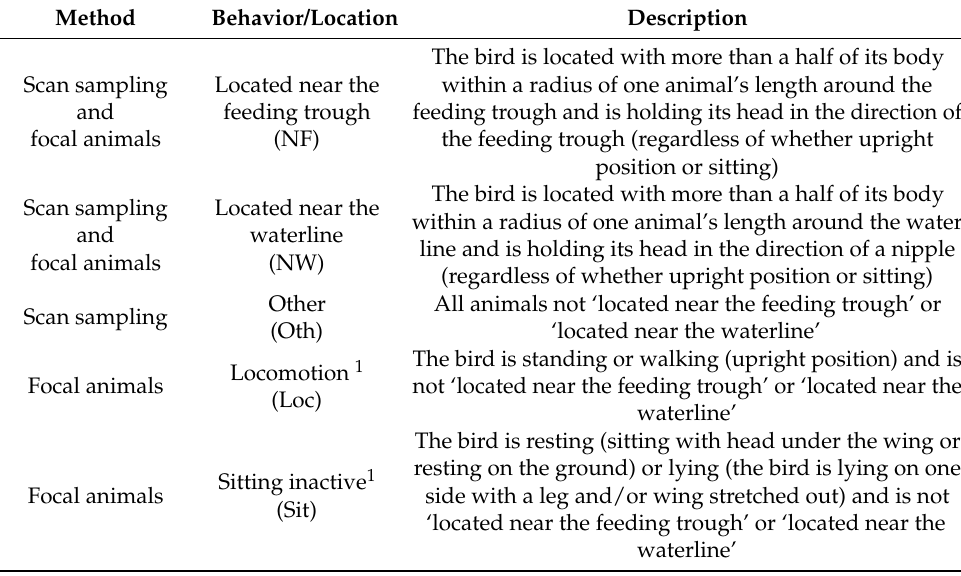
Table 1. Ethogram used in the scan sampling and in the focal animal